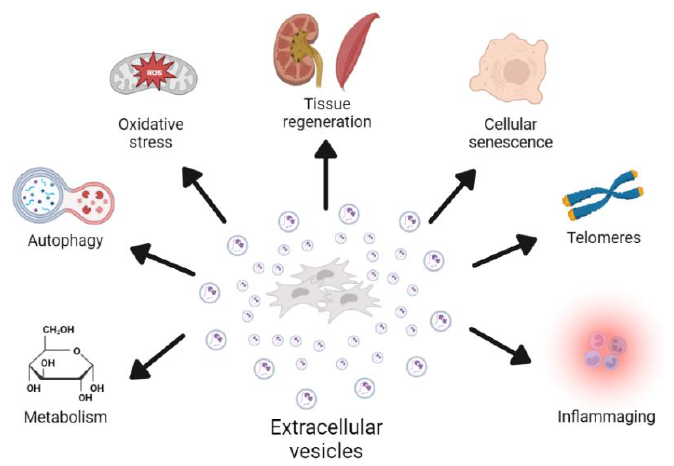
Figure 1. Graphical explanation of the role of EVs in the modulation of multiple processes associated with aging. The concrete effects of these processes are described in the manuscript, and EVs have been shown to participate in both directions. Depending on cell source and condition, EVs have beneficial or deleterious effects on age-related processes.